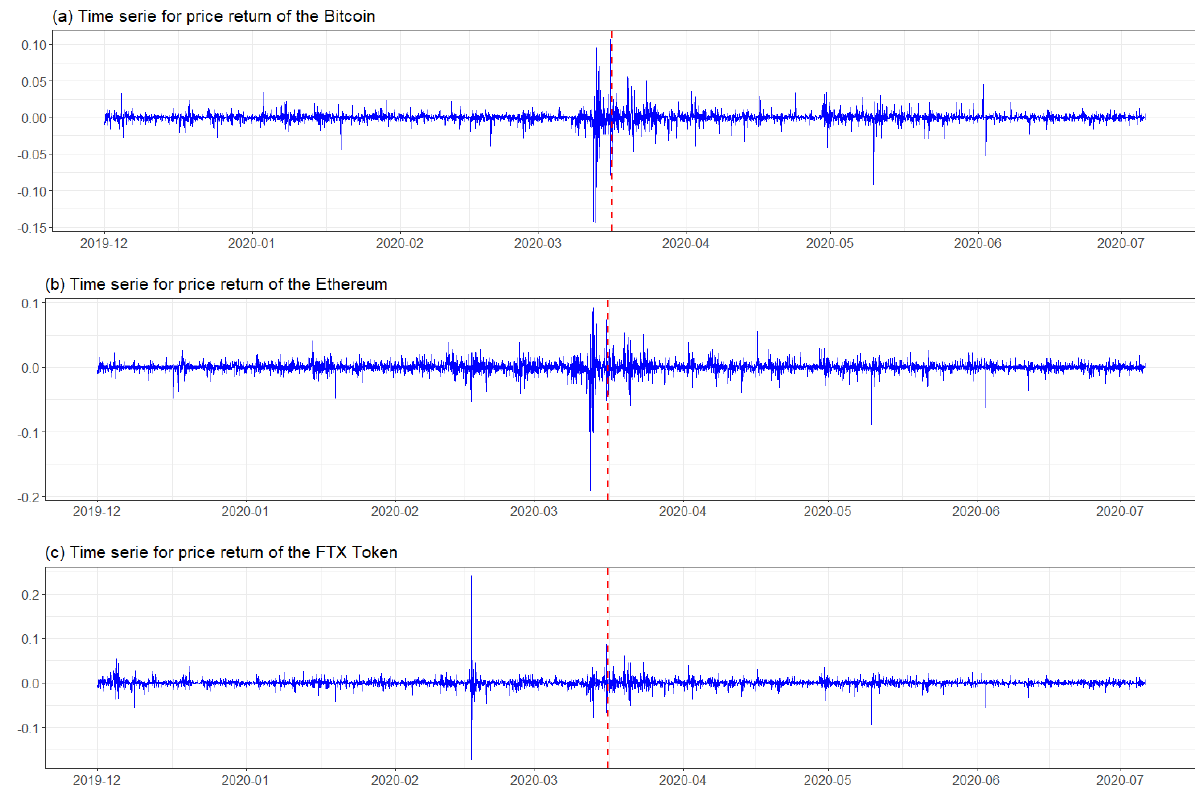
Figure 14. Time series of price returns of the main cryptocurrency as a consequence (RHS) for each subset: ( a ) Bitcoin for Subset 1, ( b ) Ethereum for Subset 2, and ( c ) FTX Token for Subset